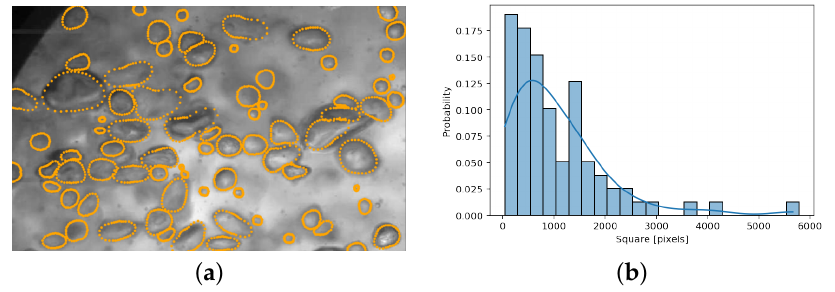
Figure 30. StarDist method application: bubble boundaries ( a ) and distribution of areas ( b